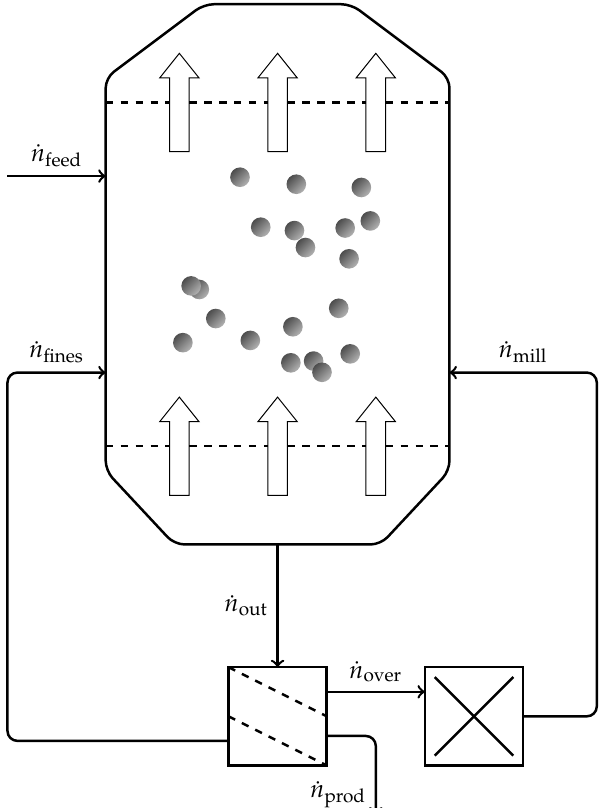
Figure 3. Schematic representation of the process chamber and periphery. Particles are fluidized in the chamber by an upwards facing air stream. Particles are withdrawn ( ˙ n out ) and sieved into three fractions ( ˙ n over , ˙ n prod , ˙ n fines ). The latter ones are feed back to the fluidization chamber and feed particles are added. The product particles are removed from the process while oversized particles are milled and then fed back to the fluidization chamber ( ˙ n mill